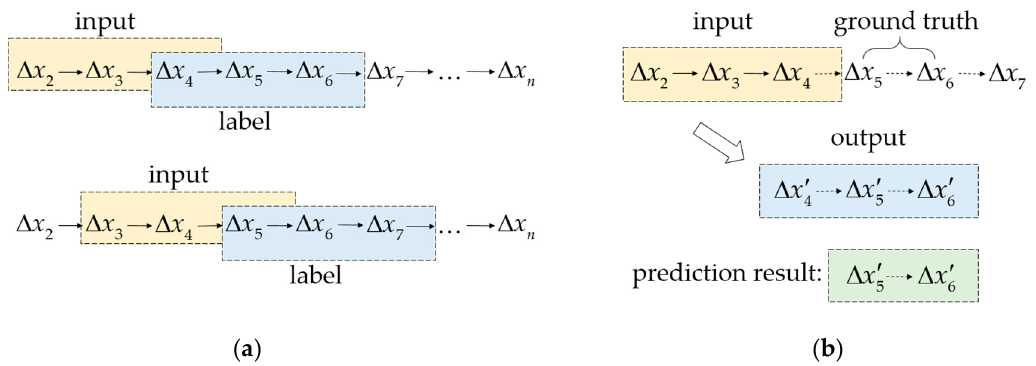
Figure 2. Schematic of generating the training data and test data when input sequence length k = 3, prediction length l = 2. ( a ) Generating training input and label with a sliding window. ( b ) Test input, ground truth, and prediction results.